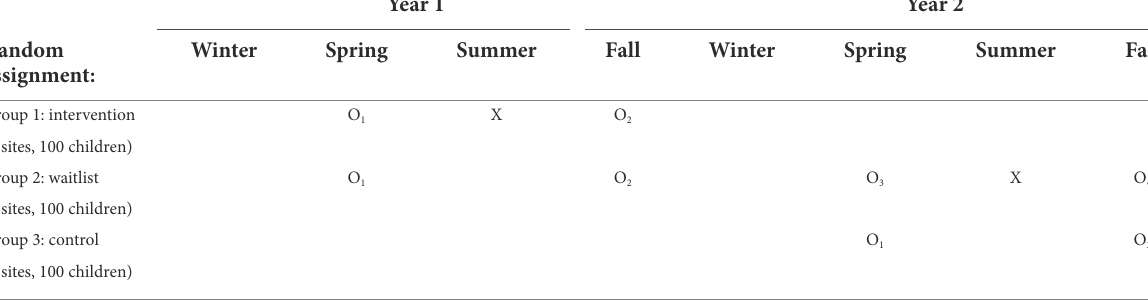
TABLE 1 Research design with intervention, waitlist (delayed intervention), and control